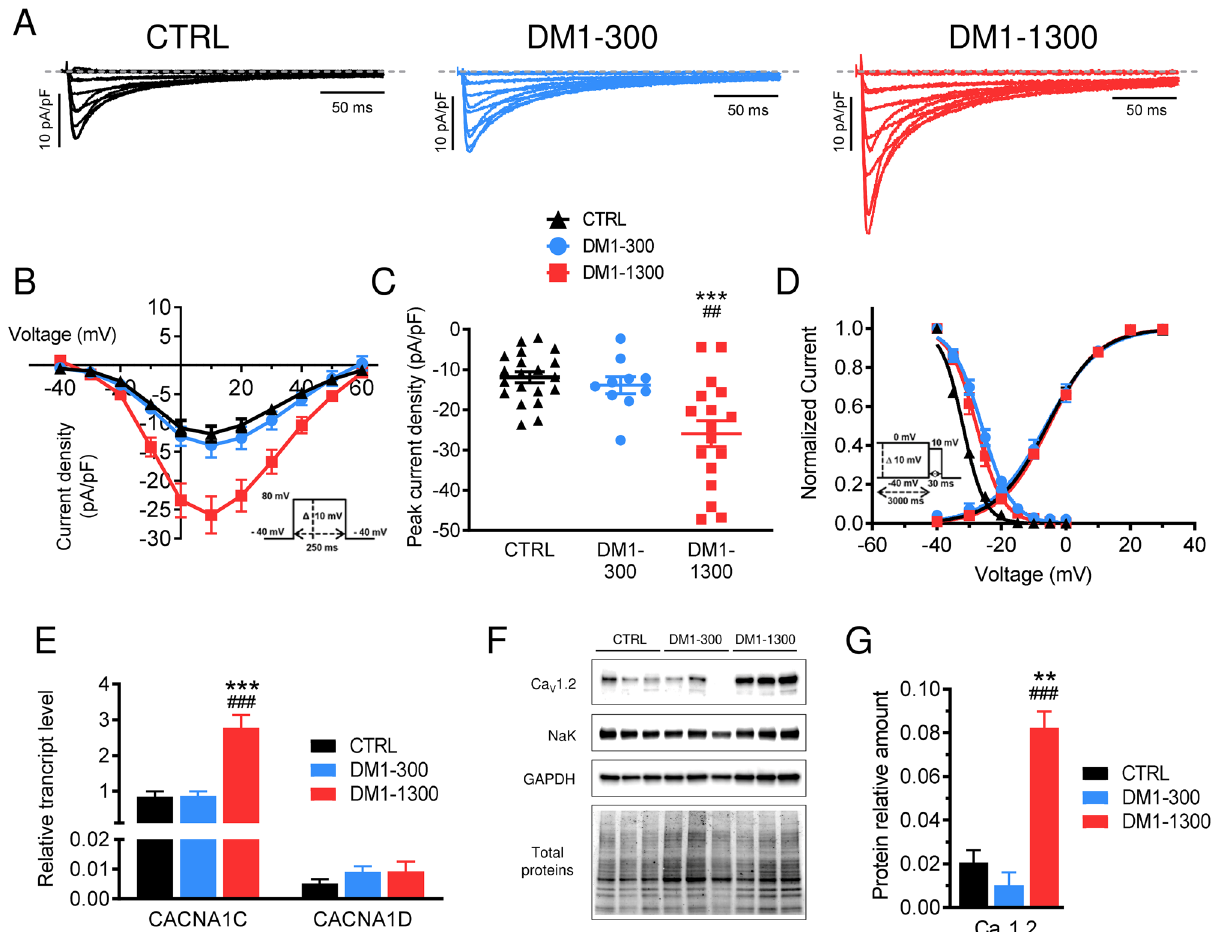
Figure 4. L-type calcium current density is higher in iPSC-CMs from the DM1-1300 patient. ( A ) Representative L-type Ca 2+ current traces recorded from CTRL, DM1-300, and DM1-1300 iPSC-CMs. The dashed line represents zero current ( B ) L-type Ca 2+ channel current–voltage relationships recorded in CTRL (n = 20), DM1-300 (n = 10), and DM1-1300 (n = 17) iPSC-CMs. The current was normalized to the capacitance (pF) of the cells. ( C ) Dot plot showing the L-type Ca 2+ channel current densities recorded at 10 mV. ( D ) Voltage- dependence of steady-state activation (n = 10–20) and inactivation (n = 7–9) of L-type channel Ca 2+ currents. ( E ) RT-qPCR quantification of the expression of Ca V 1.2 mRNA in iPSC-CMs. Results are expressed relative to the expression of GATA4 mRNA. ( F ) Western blot for the quantification of Ca V 1.2 protein level in CTRL, DM1-300 and DM1-1300 iPSC-CMs. The membrane was cut in three sections and blot with the selected antibody. Panel 1 to 4 (from top to bottom) show Ca V 1.2, Na/K ATPase pump, GAPDH and total proteins (uncut blot, stain-free technology) signals, respectively. For each group, three samples from three independent differentiation were analyzed. The four panels came from the same gel/blot. Brightness and contrast were adjusted. No nonlinear adjustments were applied. ( G ) Quantification of Ca V 1.2 protein level in CTRL (n = 3), DM1-300 (n = 3) and DM1-1300 (n = 3) from western blot is shown in panel F. Results are expressed relative to total protein signal. Bars indicate SEM. **p < 0.01, ***p < 0.001 (CTRL vs DM1-1300) and ## p < 0.01, ### p < 0.001 (DM1-300 vs DM1- 1300) as determined by ANOVA and Turkey’s post hoc